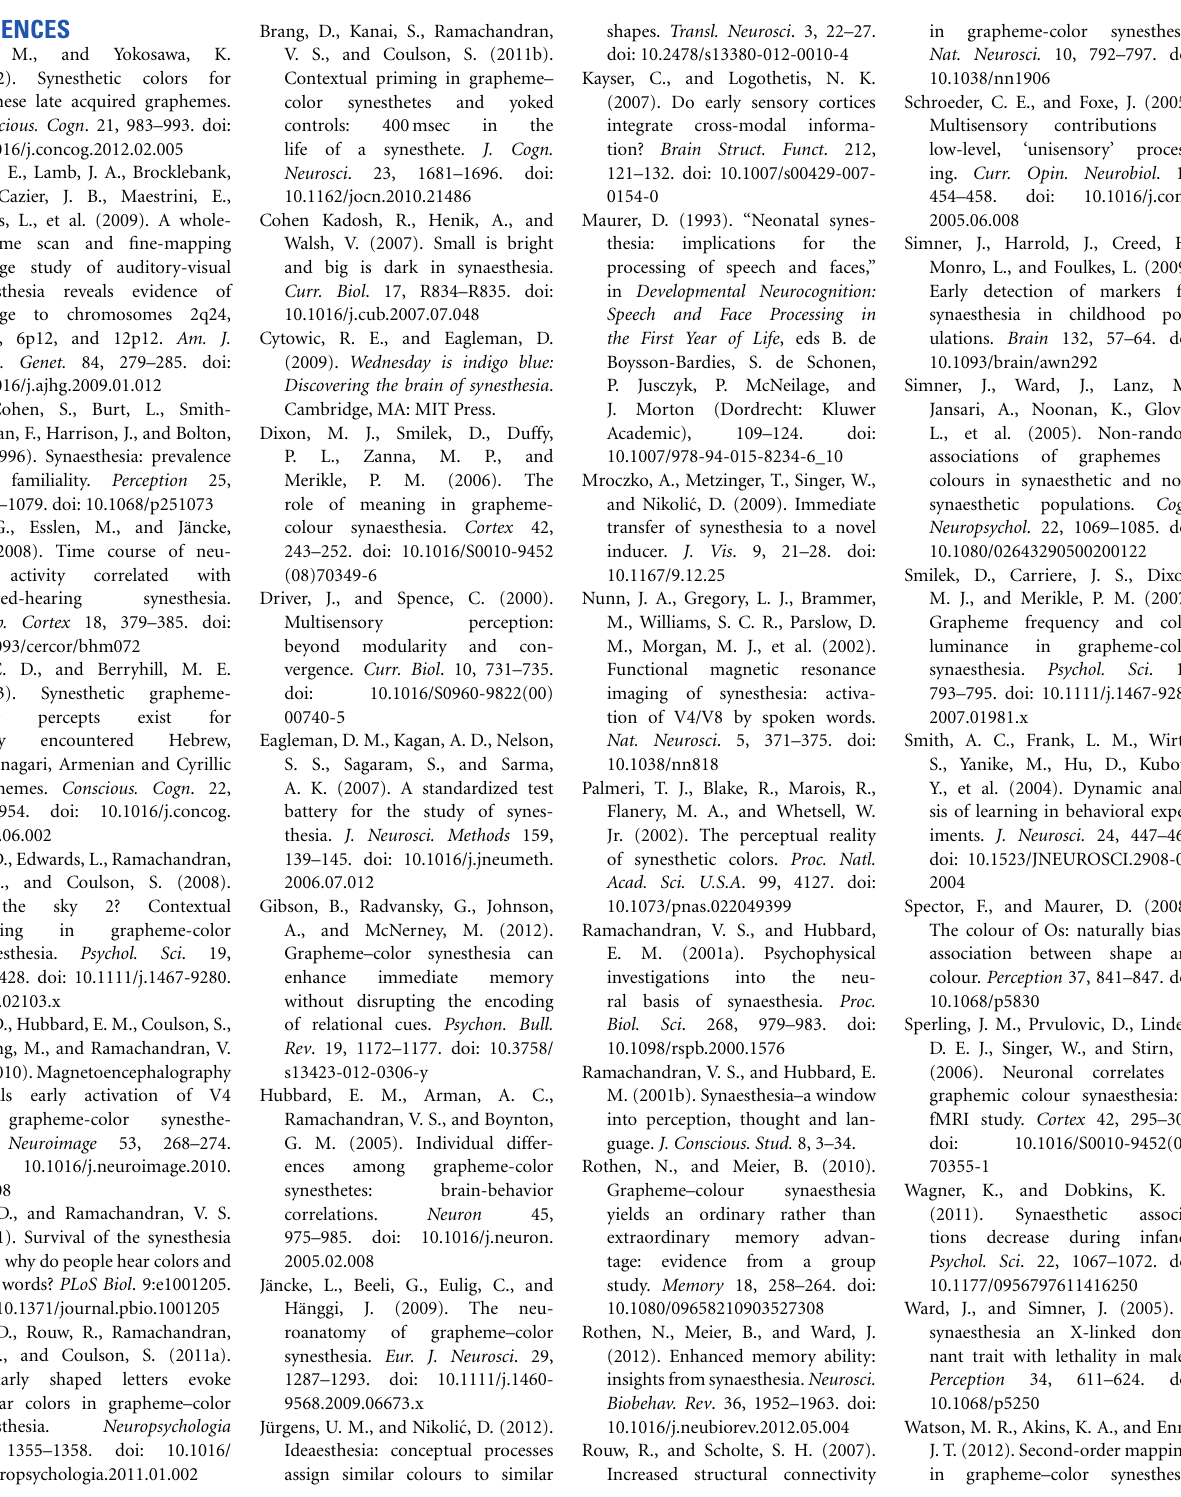
Figure S1 | Individual subject plots showing synesthetes’ (blue) and controls’ (red) data points for each of the three analyses conducted for the Guess-and-Check paradigm (A–C) and for the Congruency